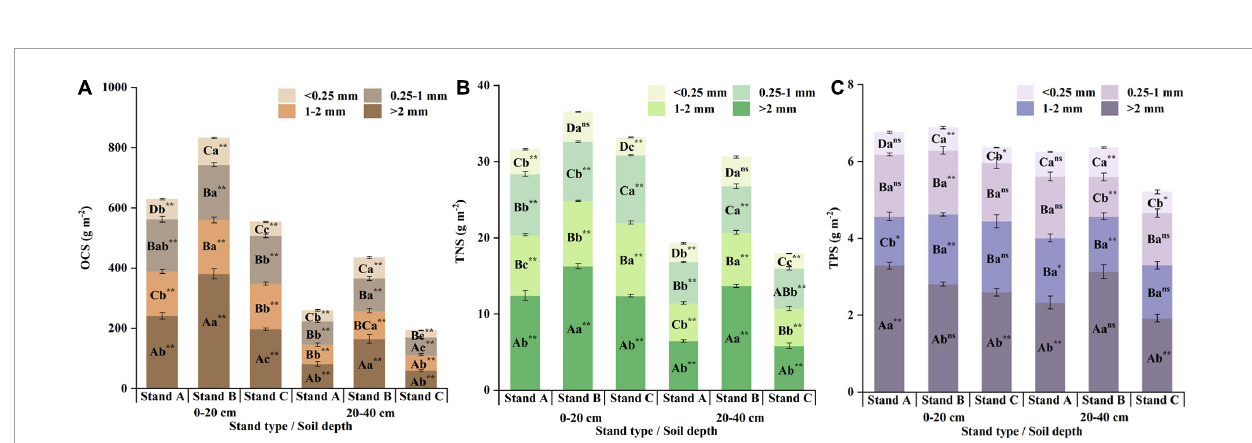
FIGURE5 Aggregate-associated OCS (A) , TNS (B) , and TPS (C) in Chinese fir plantations with different stand types. OCS, TNS and TPS stand for the stocks of organic carbon, total nitrogen, and total phosphorus in different aggregate sizes, respectively. ** and * stand for significant differences among the different soil depths at P < 0.01 and P < 0.05, respectively. ns Stands for no significant differences among the different soil depths.